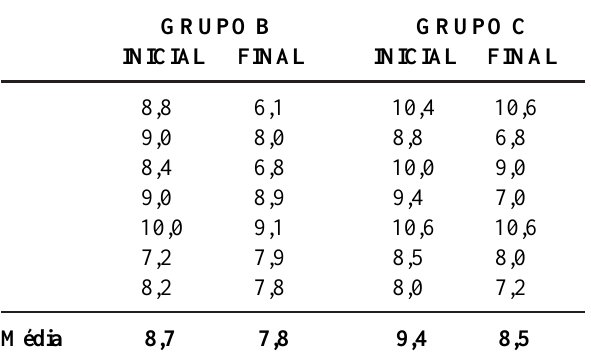
TABELA 1 - Peso (kg) dos cães dos Grupos B(com neo- válvula) e C (sem válvula ileocecal), antes e depois dos procedimentos